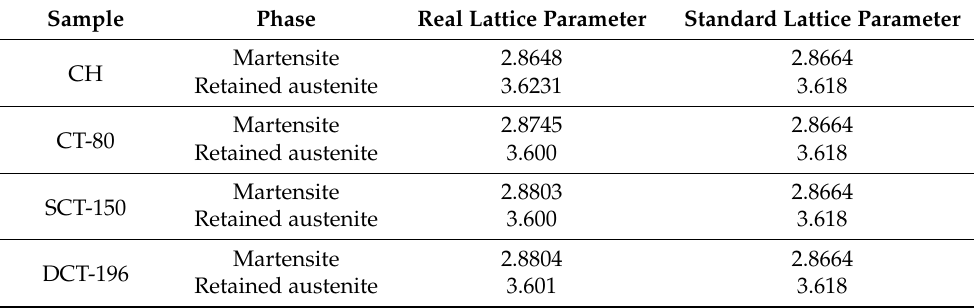
Figure 6. XRD patterns and retained austenite content of 17Cr2Ni2MoVNb steel under different cryogenic treatment processes: ( a ) XRD patterns, and ( b ) retained austenite content. Table 4. The lattice parameters of the phases in 17Cr2Ni2MoVNb steel under different cryogenic treatment processes.